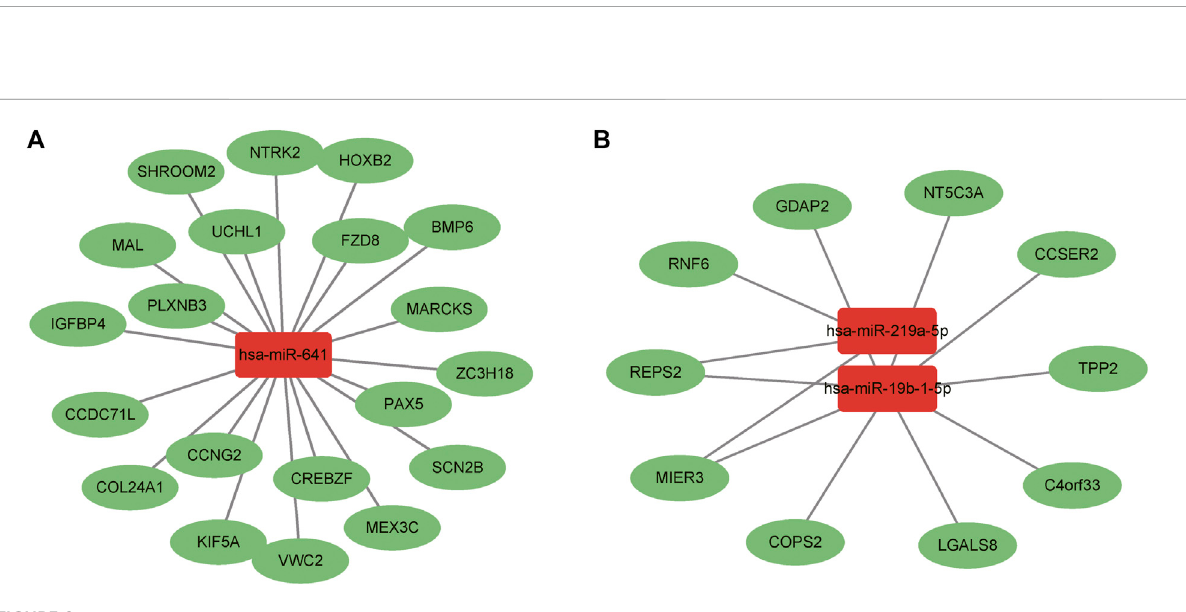
FIGURE 9 Interaction analysis between differential miRNAs and mRNAs. (A) UpregulatedmiRNAs and downregulated mRNAs. (B) Downregulated miRNAs and upregulated mRNAs. Red boxes represent miRNAs and green ovals indicate mRNAs.